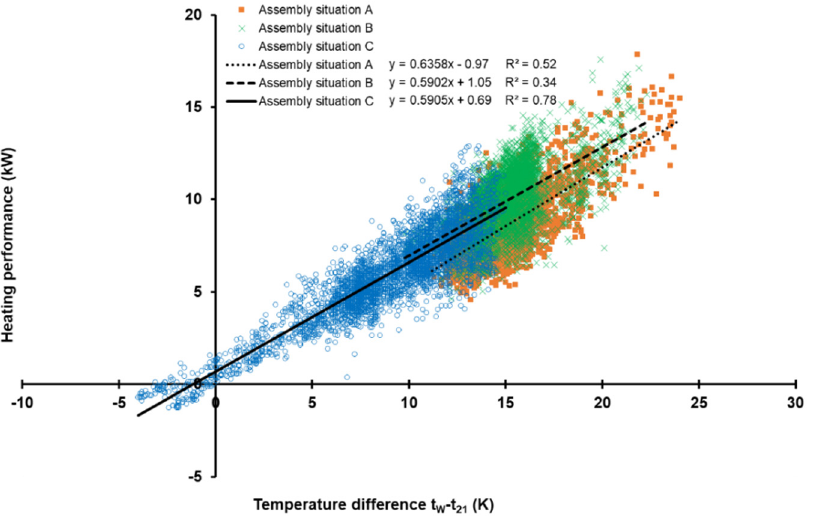
Figure 6. Data and relationship between heating performance of the exchanger scrubber pilot plant (at the three different assembly situations of the heat exchanger) and the temperature difference between scrubbing water and outside air ( Δ t W –t 21 )